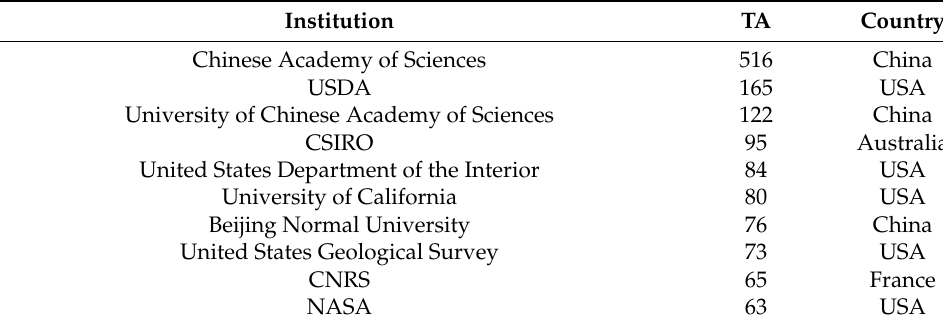
Figure 2. Top 15 main research fields in Web of Science on GRS research studies from 1980 to 2020. Table 2. Top 10 productive institutions on GRS research from 1980 to